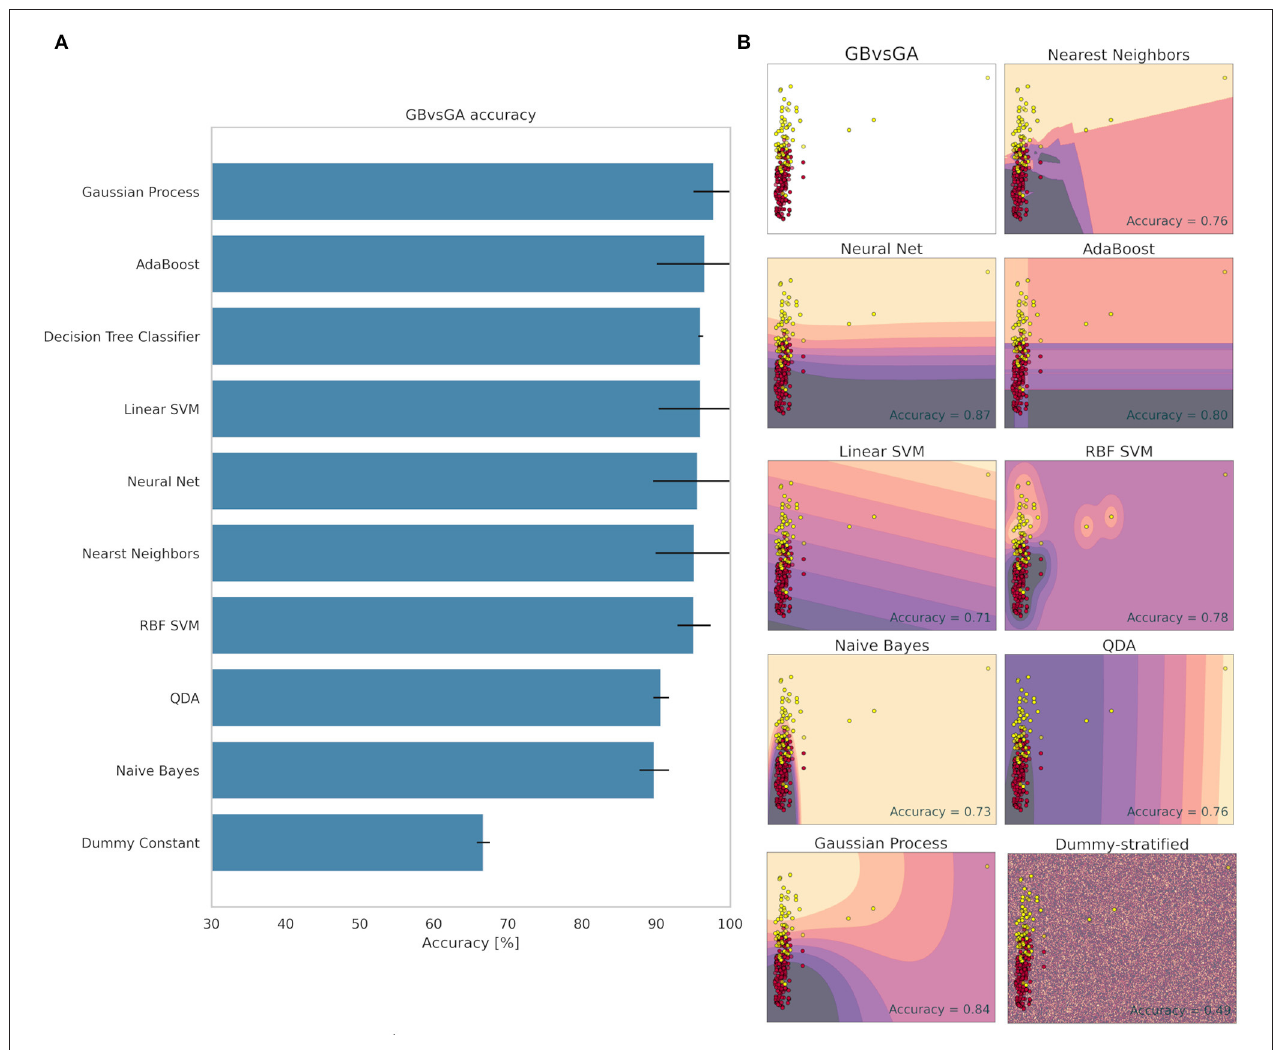
FIGURE 3 | Accuracy (%) and standard deviation (A) of the Machine Learning models used to classify GB and GA groups. Scatter plots (B) showing a sample space plan used in ML training for the GB × GA distribution. Red dots: GB; Light yellow spots: GA. The regions are the demarcations made by ML to indicate levels of certainty of classification. The darker it is, the more certain it belongs to the GB group. The clearer the more certainty of belonging to the GA group. The subtitle of each graph indicates the method used and in the lower right quadrant is the accuracy